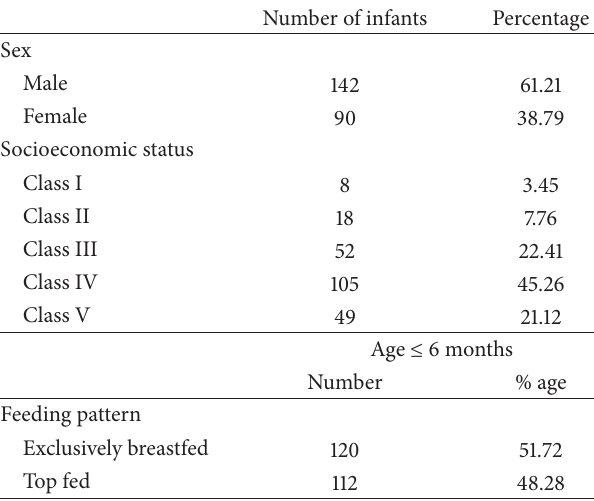
Table 1: Showing baseline data of infants. Table 2: Showing number of breastfed and top fed infants in terms of hospital stay ( < 7 days and > 7 days) due to various